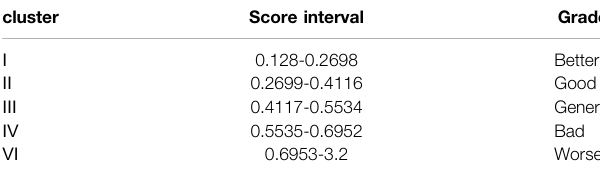
TABLE 1 | Evaluation of the monitoring wells ’ quality. TABLE 2 | Grade division of the water quality